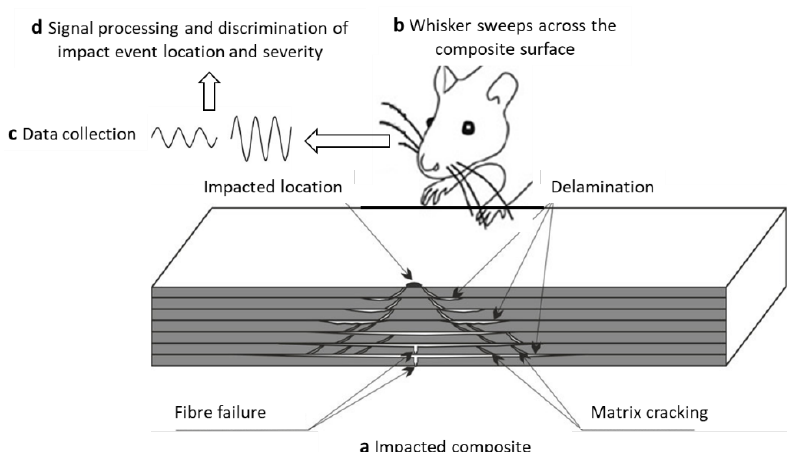
Figure 1. Overview of the project, and a schematic of a typical damage mechanisms in BVID. NDT&E strategies can be approximately classified as [2,8,9]: